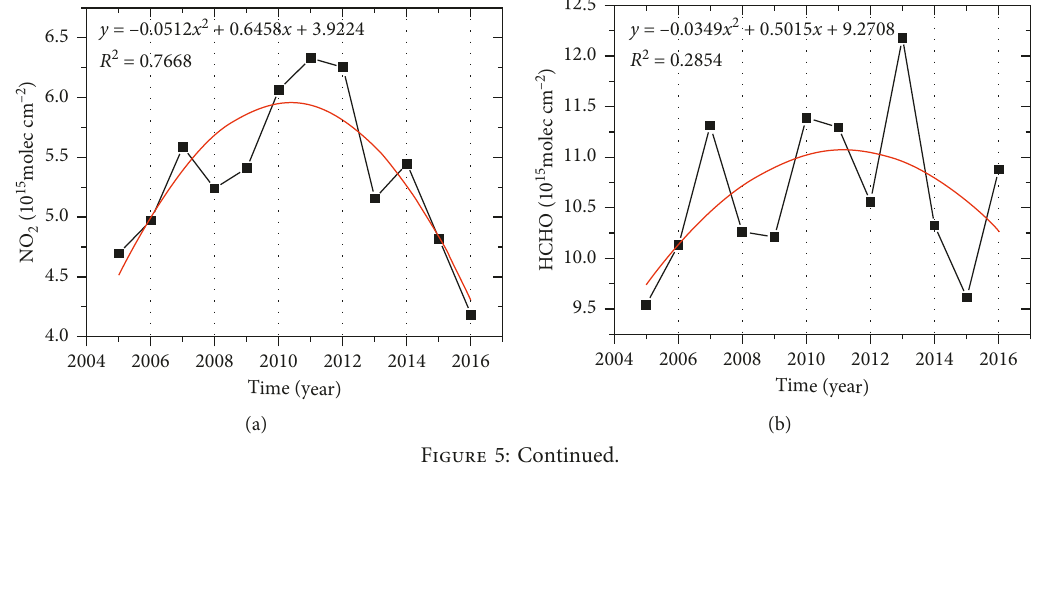
cm − 2 ). (a) 2005, (b) 2006, (c) ·